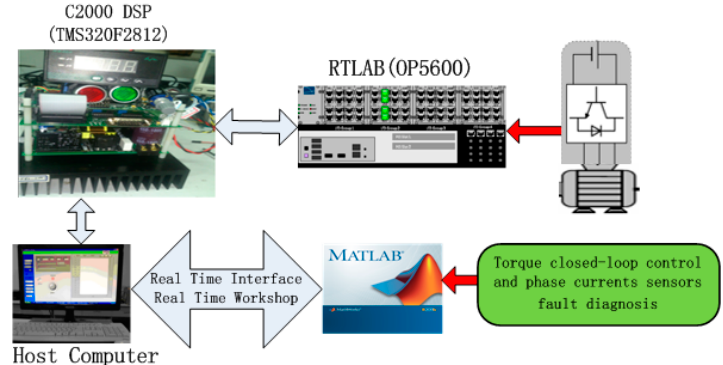
Figure 15. The configuration of RT-LAB experimental system.